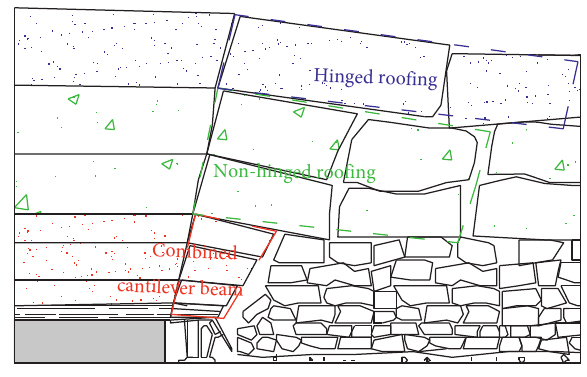
Figure 4: Roof structure model of large mining height working